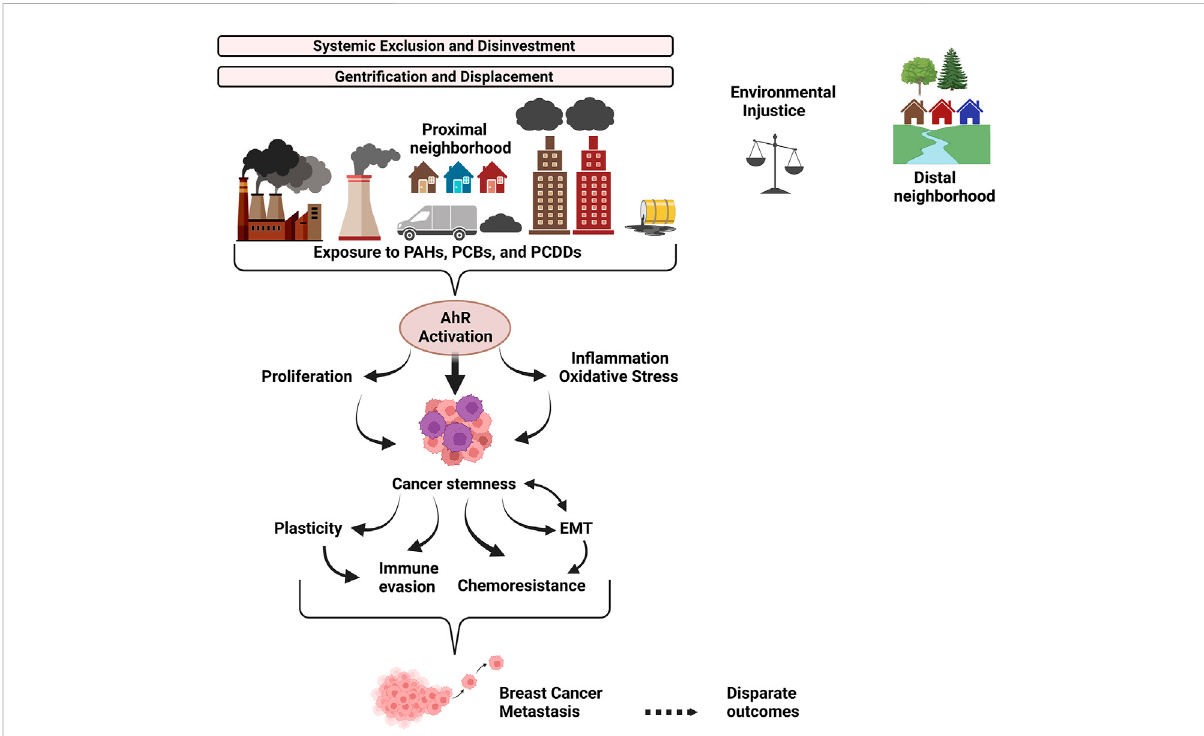
FIGURE 2 Overview of the link between systemic exclusion, environmental injustice, and AhR-driven tumor biology. Discriminatory housing and lending policies (ex: redlining) drove neighborhood racial/ethnic and socioeconomic segregation which persists today due to ongoing systemic discrimination and gentri fi cation. Resources were and are disproportionately allocated to wealthier neighborhoods, contributing to neighborhood disinvestment. The proximal neighborhood has more traf fi c, pollution-generating factories and dump sites. It has less green space for stress relief and exercise, worsening the riskscape that individuals in the proximal neighborhood must navigate. Individuals living in the proximal neighborhood are chronically exposed to environmental toxins, tipping the scales of environmental justice against them. Polycyclic aromatic hydrocarbons(PAHs),Polychlorinateddibenzo-p-dioxins(PCDDs),andPolychlorinatedbiphenyls(PCBs)aregeneratedbycombustionprocessesas components of ambient particulate matter (PM) derived from urban areas and industrial activities. PAHs, PCDDs and PCBs robustly activate the AhR signaling pathway, promoting cancer stemness and interrelated functional outcomes, including plasticity, chemoresistance, EMT and immune evasion, which synergize to drive breast cancer metastasis and disparate outcomes for individuals in proximal